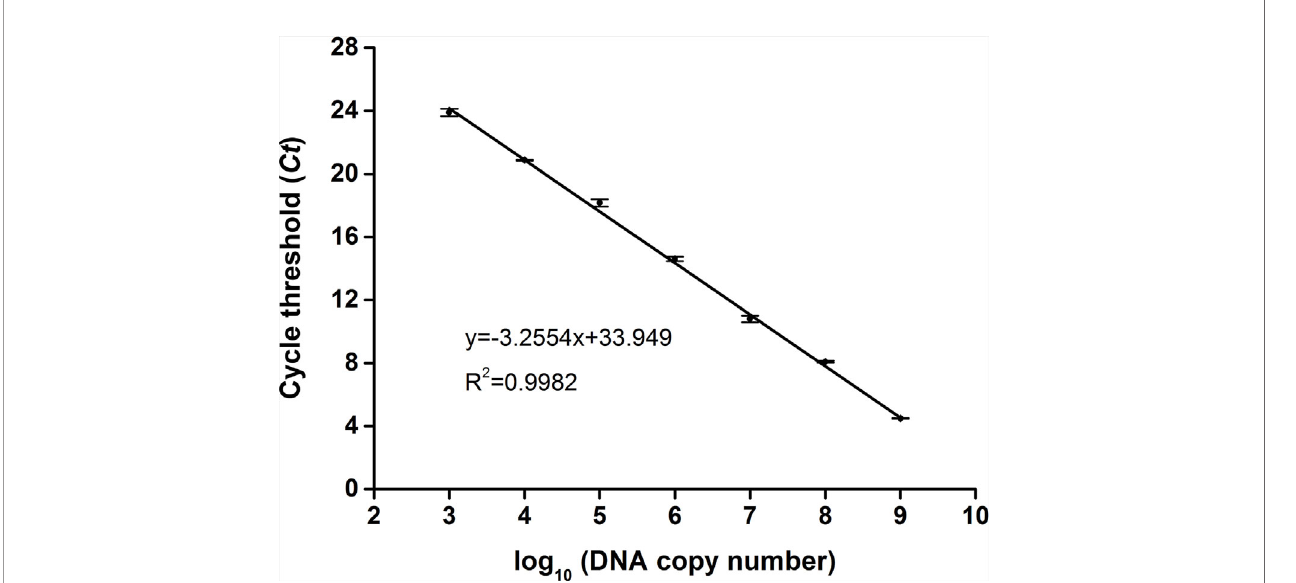
FIGURE 2 | Standard curve of swp gene fragment by qPCR. For each reaction, 1 m l of the standard plasmid between 10 3 and 10 9 copies/ m l was used as the template. The standard curve representing the correlation between the DNA copy number and the qPCR cycle threshold ( Ct ) value was built using GraphPad Prism 8.0 (GraphPad Software Inc, San Diego, CA). The function of the standard curve and the R 2 value are indicated. The error bars represent the mean and standard error of three qPCR